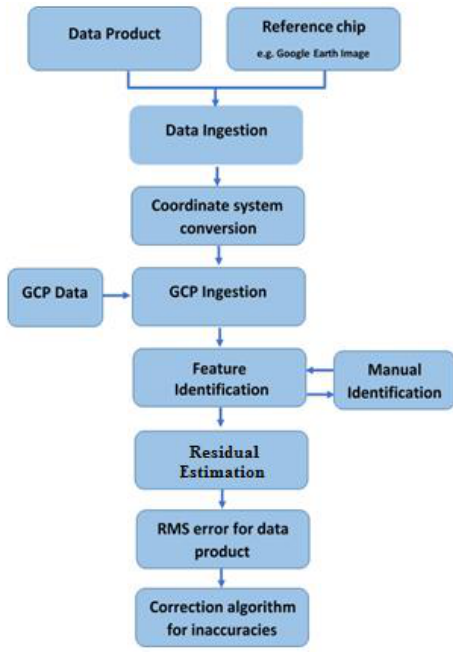
Figure 1. Software